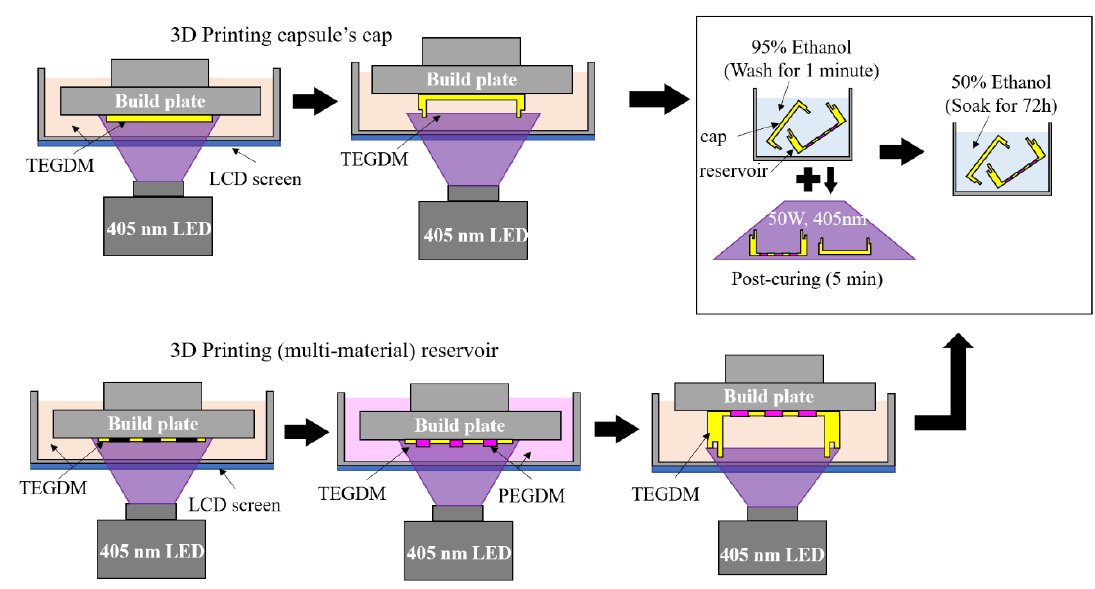
Figure A1. 3D printing cell-encapsulation capsule. The cap was printed with TEGDM, whereas the reservoir was printed with both TEGDM and PEGDM. After 3D printing, both parts were washed with 95% ethanol for 1 min, followed by post-curing in UV box (50 W, 405 nm) for 5 min. Finally, 3D printed parts were soaked in 50% ethanol for 72 h to remove photo initiator and photosensitizer and increase biocompatibility of the capsule.